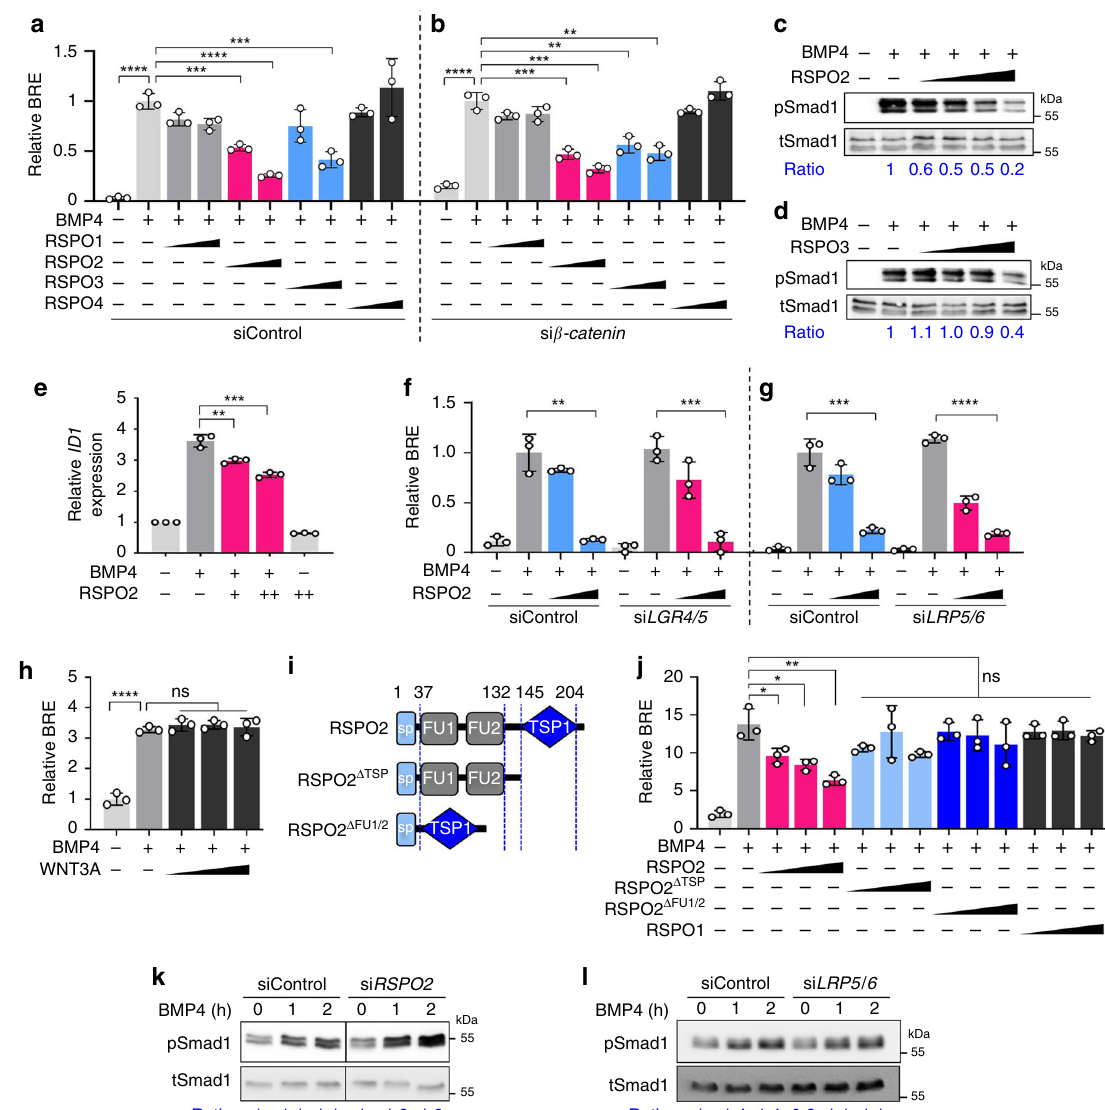
Fig. 1 RSPO2 and RSPO3 antagonize BMP4 signaling WNT independently. a , b BRE reporter assay in HEPG2 cells upon siControl ( a ) or si β -catenin ( b ) transfection, with or without overnight BMP4 and RSPO1-4 treatment as indicated. n = 3 biologically independent samples. c , d Western blot analyses of phosphorylated Smad1 (pSmad1) and total Smad1 (tSmad1) in HEPG2 cells stimulated by BMP4, treated with or without increasing amount of RSPO2 ( c ) or RSPO3 ( d ) overnight. Cells were starved 3 – 6 h before the stimulation. Ratio, relative levels of pSmad1 normalized to tSmad1. Representative data from two independent experiments are shown. e qRT-PCR analysis of BMP target ID1 in HEPG2 cells upon BMP4, with or without overnightRSPO2 treatment. n = 3 experimentally independent samples. Data are displayed as means± SD. ** P < 0.01, *** P < 0.001 from two-tailed unpaired t -test. f , g BRE reporter assay in HEPG2 cells upon si LRP5 / 6 and si LGR4 / 5 knockdowns, with or without overnight BMP4 and RSPO2 treatment as indicated. n = 3 biologically independent samples. h BRE reporter assay in HEPG2 cells stimulated overnight by BMP4 with or without increasing amount of WNT3A treatment. WNT3A activity was validated in Supplementary Fig. 1b. n = 3 biologically independent samples. i Domain structures of RSPO2 and deletion mutants used in j . sp, signal peptide; FU, furin domain; TSP1, thrombospondin domain 1. j BRE reporter assay in HEPG2 cells stimulated overnight with BMP4, and with or without RSPO2 WT or FU1/2 or TSP1 deletion mutants, respectively. n = 3 biologically independent samples. Data for reporter assays ( a , b , f – h , j ) are displayed as means ± SD, and show a representative of multiple independent experiments. ns, not signi fi cant; * P < 0.05, ** P < 0.01, *** P < 0.001, and **** P < 0.0001 from two-tailed unpaired t -test ( a , b , f , g , j ) or one-way ANOVA with Dunnett test ( h ). k , l Western blot analyses of phosphorylated Smad1 (pSmad1) and total Smad1 (tSmad1) in H1581 cells upon siRNA transfection as indicated, with 0 h, 1 h, and 2 h of BMP4 stimulation. Ratio, relative levels of pSmad1 normalized to tSmad1. Representative data from two independent experiments are